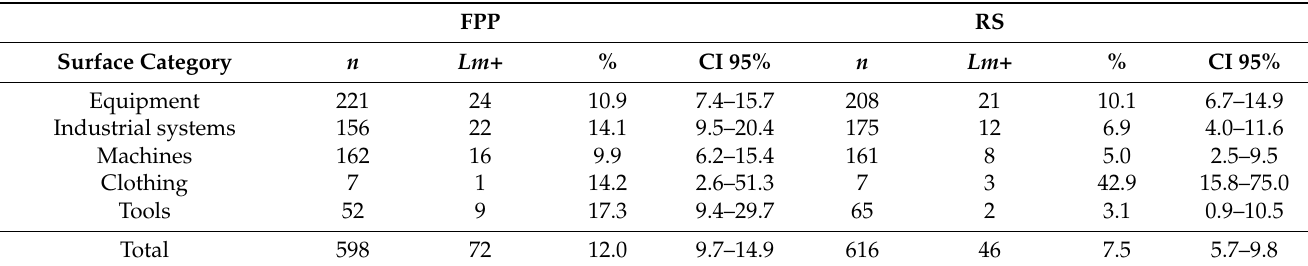
Table 3. Results of the samples tested reported based on the FPP or RS and category of surfaces ( n = 1214 *). FPP RS Surface